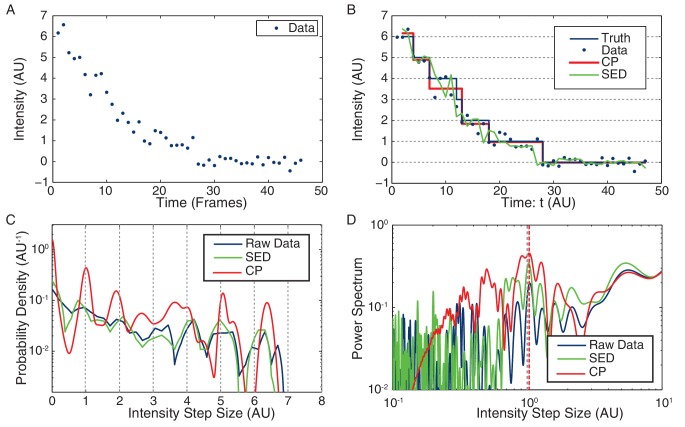
Stoichiometry calculation applied to simulated data.(A) Simulated intensity data. A bleaching experiment was simulated to demonstrate the performance of the CP Algorithm against the SED filter. The noise and trace length were chosen to closely approximate the observed data. (B) Idealized intensity traces. The data (blue dots) is identical to Panel a. True simulated mean (Truth) is shown in blue. There is excellent agreement between the truth (blue) and the CP idealization (red). The SED filtered trace is shown in green. (C) Pairwise intensity difference probability distribution (PDPD). The black dotted lines represent multiples of the true step-size 1 AU. (D) Power spectrum of the PDPD. The largest peak in the power spectrum is selected as the unitary step (red dotted). The true step-size is also shown (black dotted).